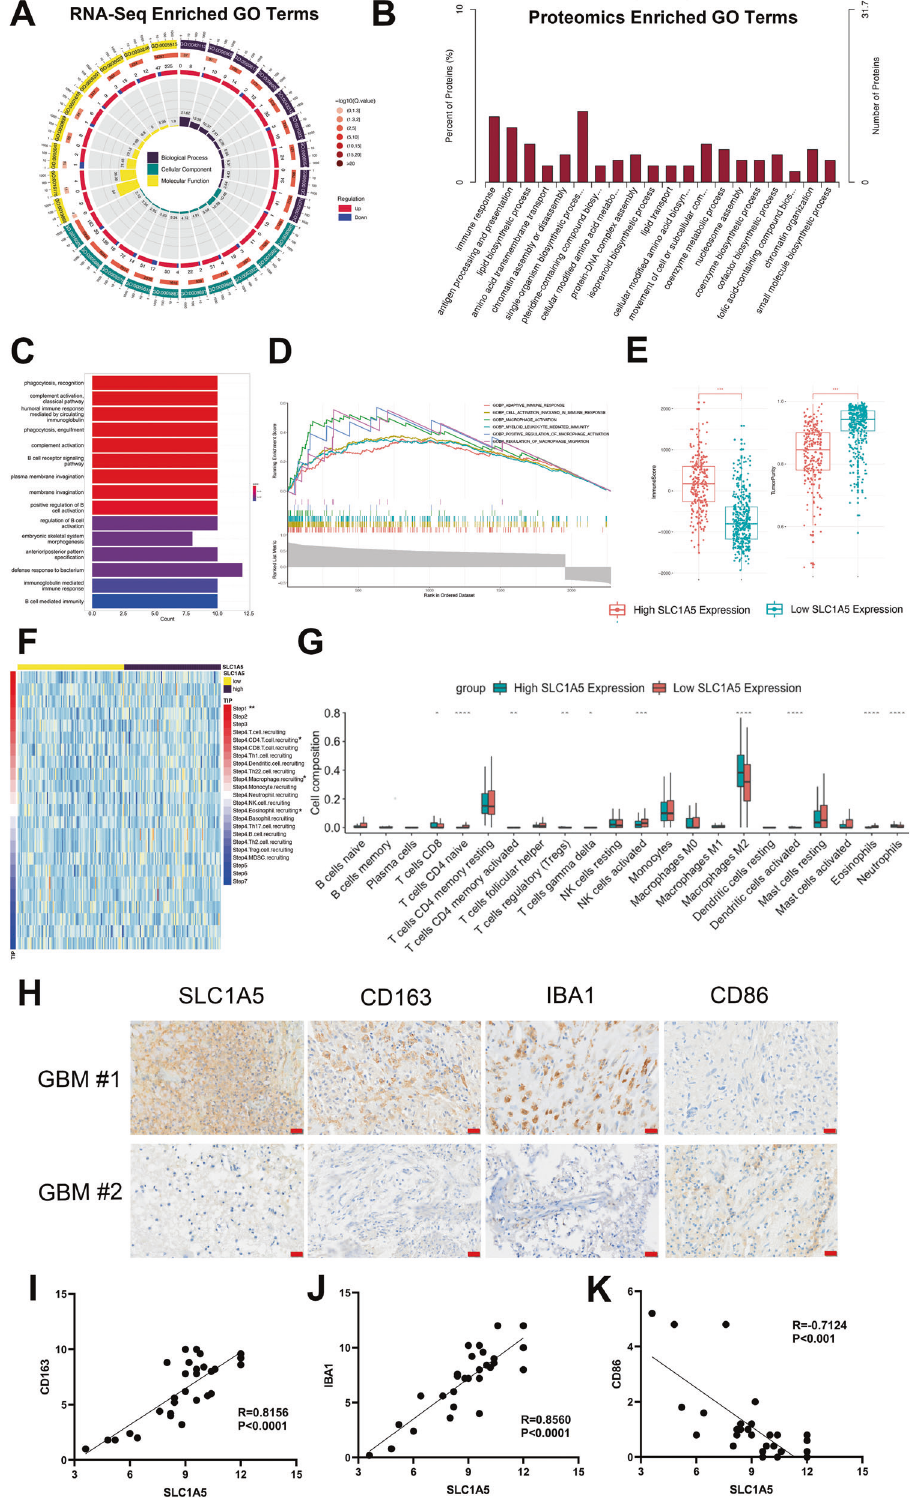
Fig. 7 SLC1A5 was associated with the in fi ltration of TAMs in glioma tissues. A GO enrichment analysis of DEGs between shCtrl and sh- SLC1A5 groups through RNA-sequence. B GO enrichment analysis of differentially expressed proteins between two groups through proteomics analysis. C GO enrichment analysis of the SLC1A5-related genes in TCGA cohort. D GSEA enrichment analysis of the SLC1A5- related genes in TCGA cohort. E The association of immune scores, tumor purity and SLC1A5 expression in TCGA cohort. F The relationship between tumor immunophenotype and SLC1A5 expression in TCGA cohort. G CIBERSORT analysis of the in fi ltration of immune cells between SLC1A5 high- and low-expression group in TCGA cohort. H The IHC results showing the expression of CD163, IBA-1 and CD86 in GBM tissues with different expression of SLC1A5 (Scale Bar = 20 μ m). I – K The correlation between the expression of SLC1A5 and the expression of CD163 ( F ), IBA-1 ( G ) or CD86 ( H ) in GBM tissues. Cell Death and Disease (2022)